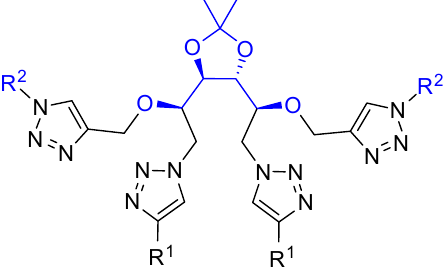
Scheme 6. General structure of Table 2. Hydrophilic–lipophilic balance (HLB) value of amphiphiles ( 20–25 ) determined using Griffin equation [35].